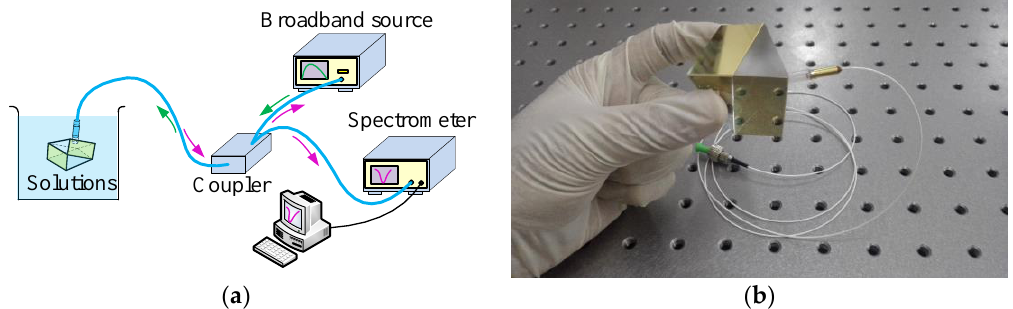
Figure 3. ( a ) Experimental setup for detect the refractive index of aqueous solution; and ( b ) Photograph of sensor based on bi-prism.